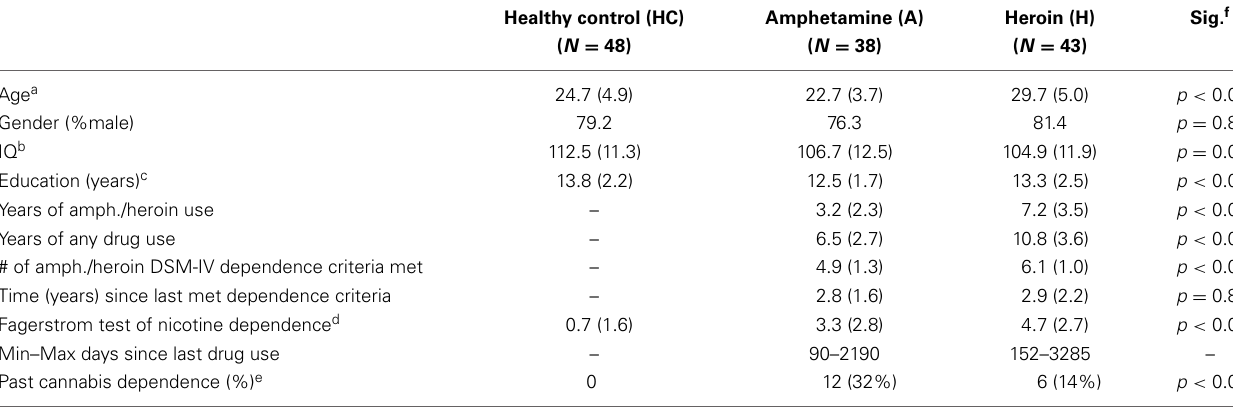
Table 1 | Demographic and substance use characteristics of participants.